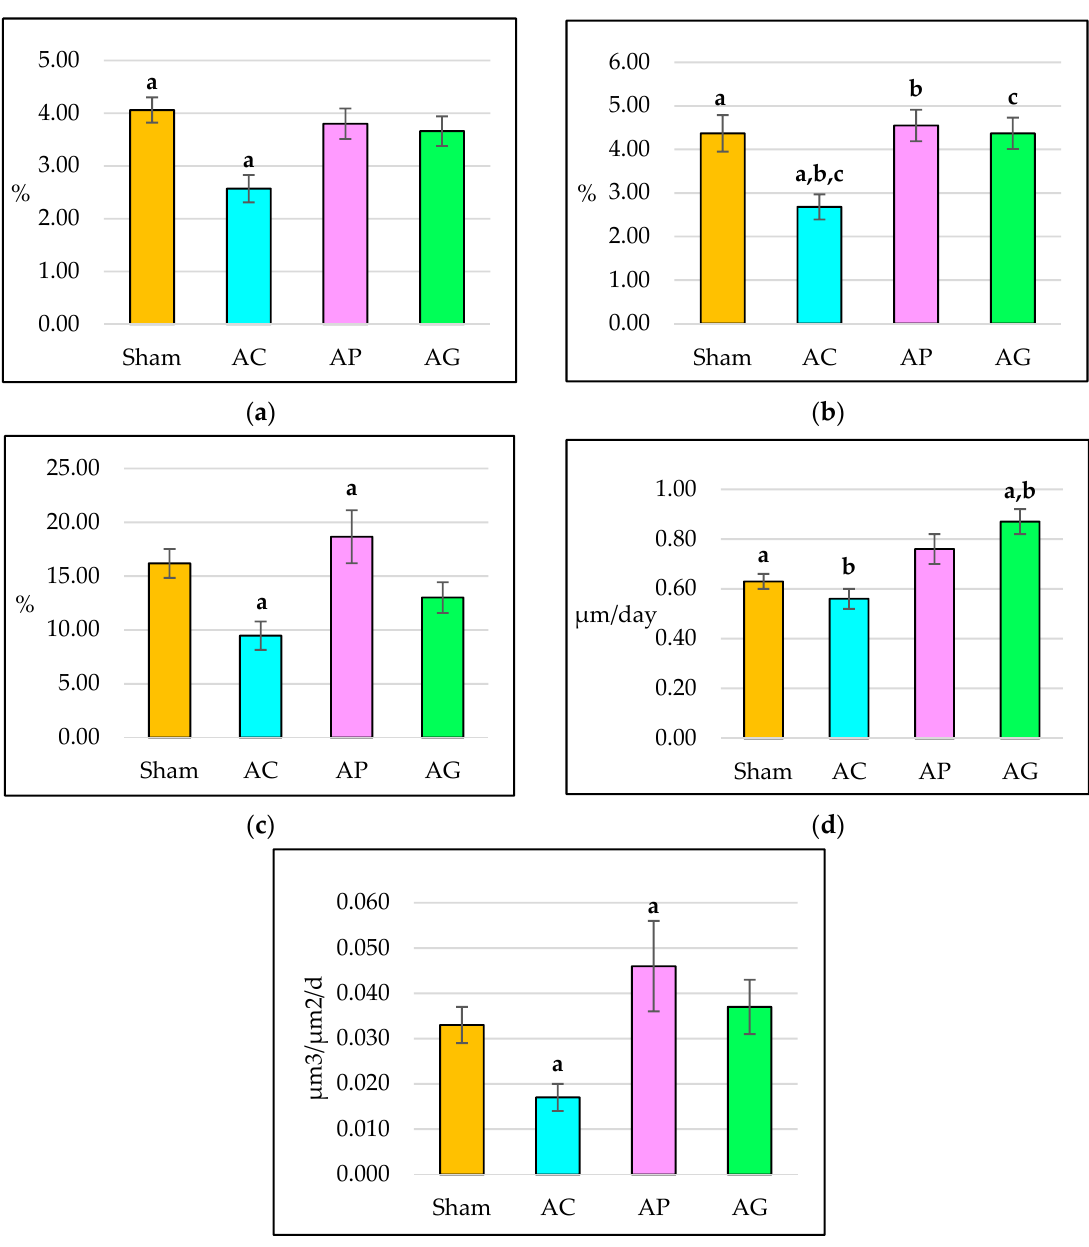
Figure 6. Dynamic trabecular histomorphometry parameters after 8 weeks of treatment: ( a ) Single-labelled trabecular surface (sLS / BS); ( b ) Double-labelled trabecular surface (dLS / BS); ( c ) Mineralized surface (MS / BS); ( d ) Mineral apposition rate (MAR); ( e ) Bone formation rate (BFR / BS). AC: Adrx control given IM DEX 120 µ g / kg / day; AP: Adrx rats given IM DEX 120 µ g / kg / day and aqueous Piper sarmentosum extract 125 mg / kg / day; and AG: Adrx rats given IM DEX 120 µ g / kg / day and GCA 120 mg / kg / day. Data presented as mean ± SEM. The same letters indicate significant di ff erences between groups at p <